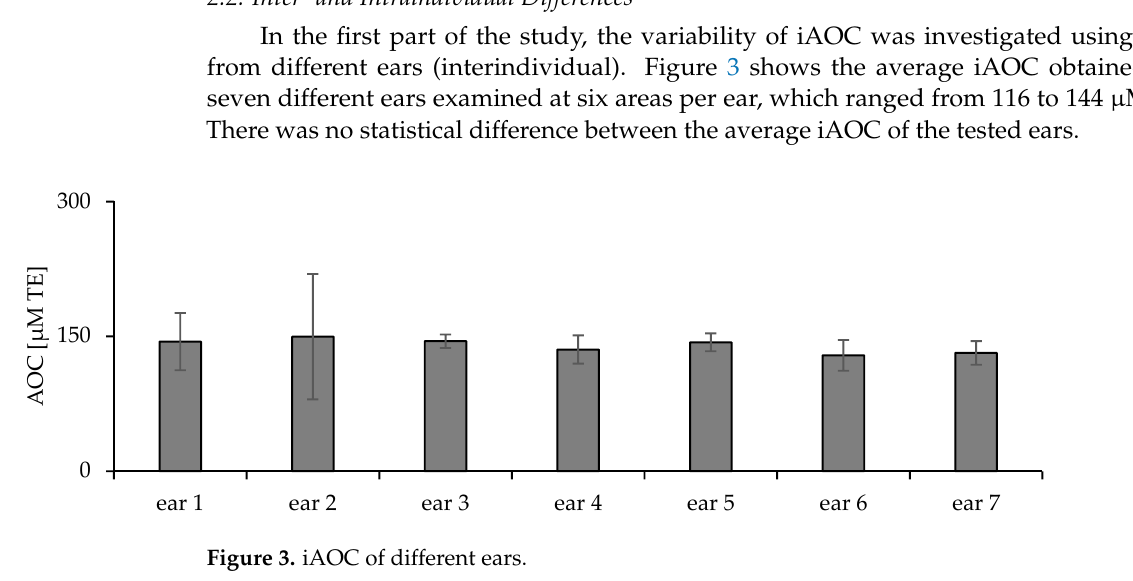
Figure 2. ORAC assay decay curves for Trolox and skin sample.